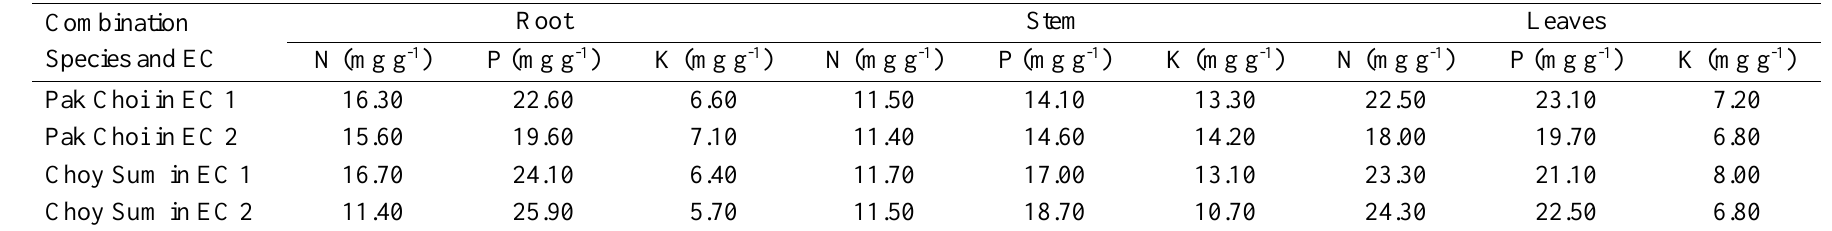
Table 5. The weight of N, P, K uptake (mg g -1 ) in root, stem and leaves on combination of species and electrical conductivity Combination Species and